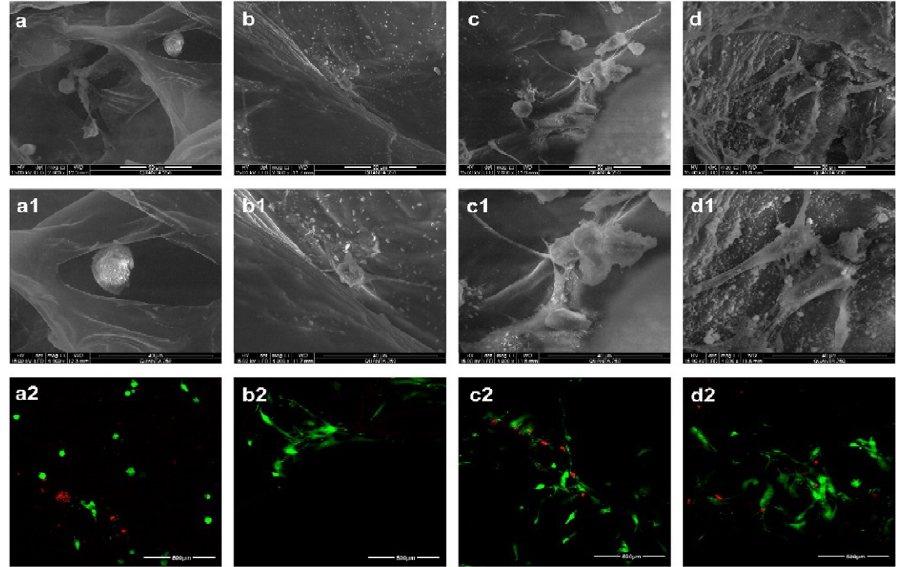
Figure 9. Morphology and viability of hBMSCs seeded in BC ( a – a2 ), BC/Gel ( b – b2 ), BC/PA/Gel ( c – c2 ), and BC/PA/Gel/HAp ( d – d2 ) scaffolds for 1 day by SEM and 3 days by live/dead staining. Original magnification: 2000 × ( a – d ), 4000 × ( a1 – d1 ), and 200 × ( a2 – d2 ). Live and dead cells were stained with green and red, respectively. Reproduced with permission from [143]. Elsevier,